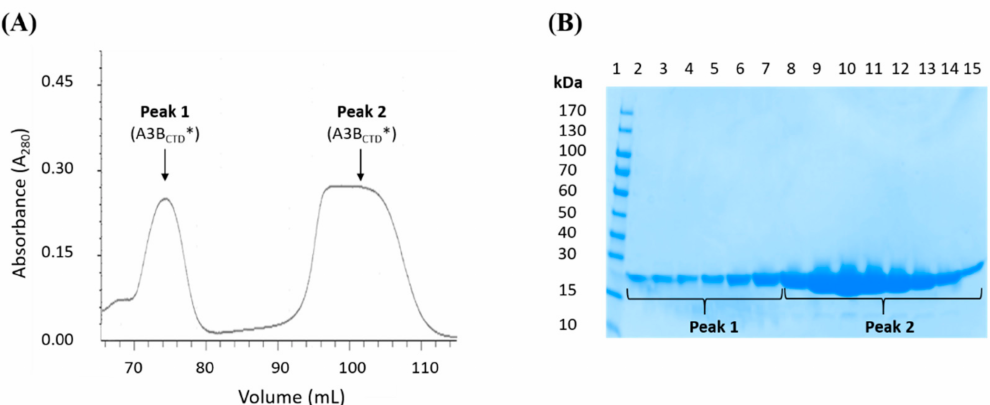
Figure 5. SEC-FPLC purification of the A3B CTD * multimers. ( A ) SEC-FPLC of A3B CTD * run through a SEC column at a flow rate of 0.5 mL/min at 25 ◦ C, displaying the elution of two forms of A3B CTD *, peak 1 and peak 2. ( B ) 16% Tricine SDS-PAGE gel (reducing conditions) of the purified A3B CTD * fractions after SEC